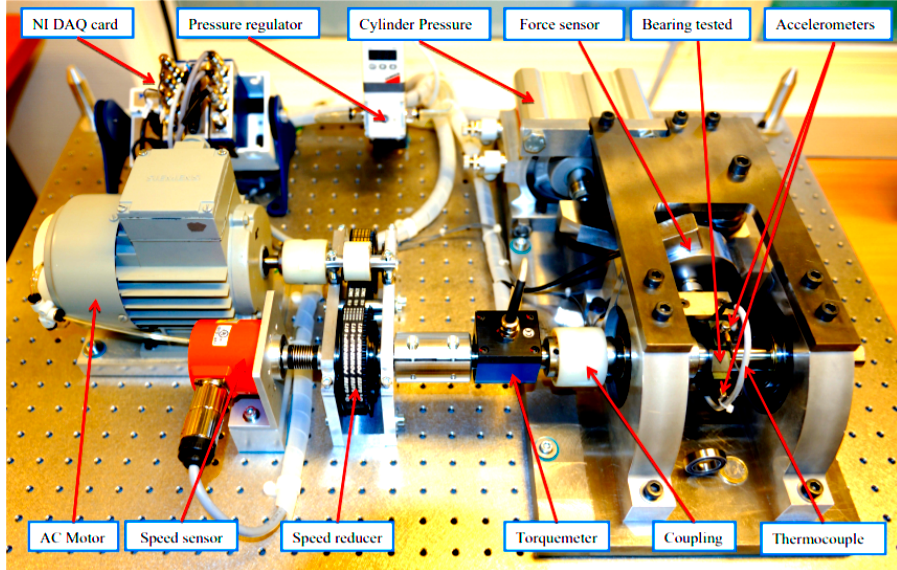
Figure 2. Overview of PRONOSTIA [27]. Table 1. FEMTO bearing dataset